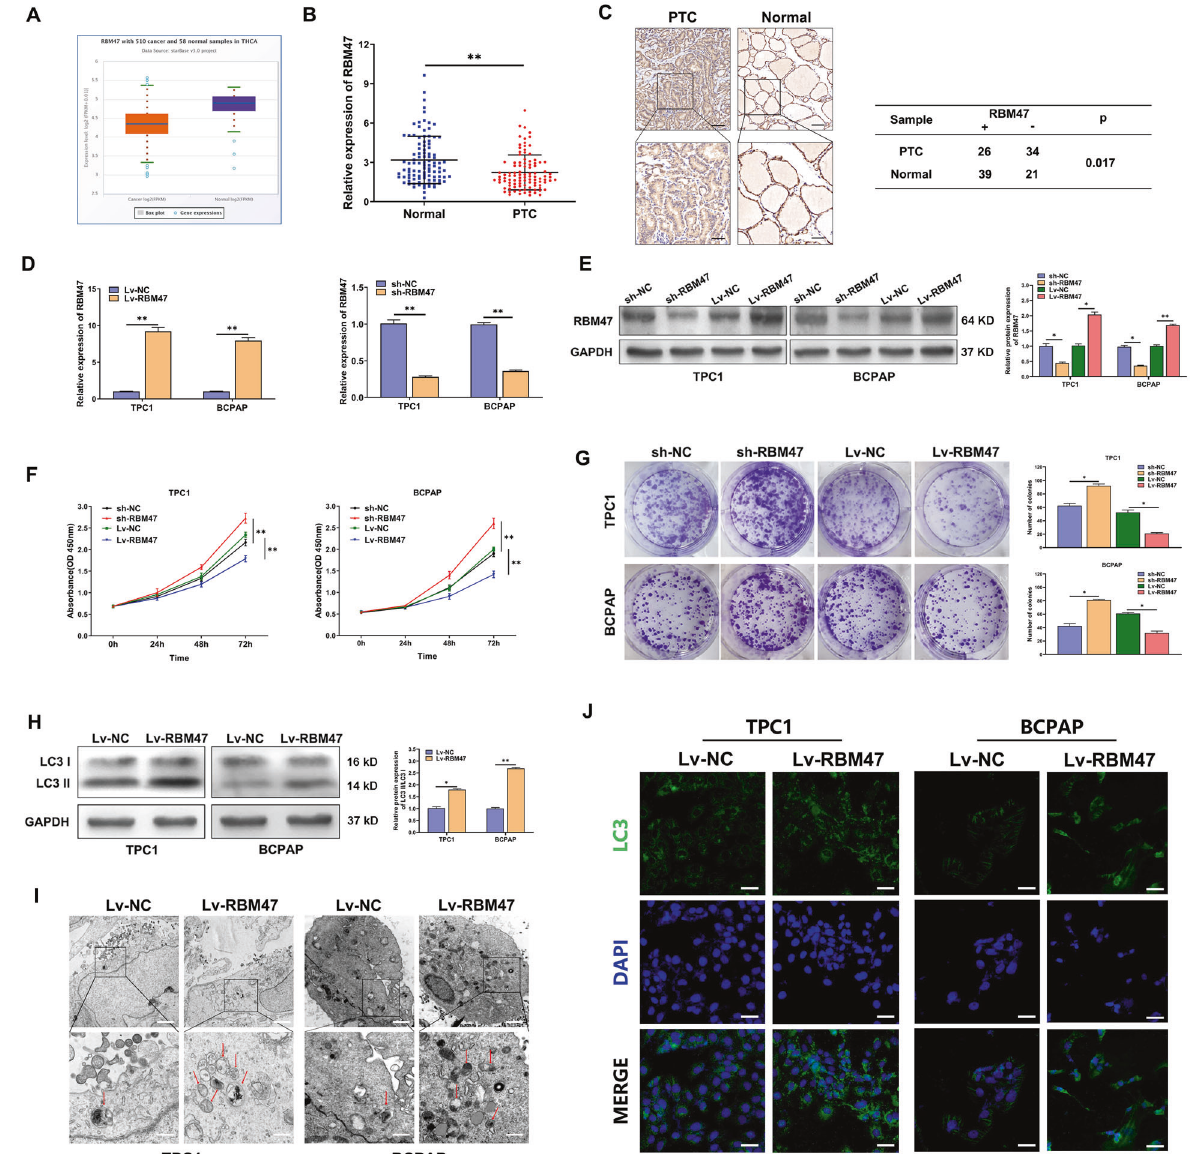
Fig. 1 RBM47 inhibits proliferation and activates autophagy in PTC cells. A RBM47 expression in PTC tissues and normal tissues from TCGA database. B The relative mRNA expression of RBM47 in 100 paired PTC tissues and adjacent non-cancerous tissues. C Representative RBM47 IHC staining of PTC tissues and matched adjacent non-cancerous tissues. Scale bar = 50 μ m (Upper) and 20 μ m (Below). D , E The transfection ef fi ciency of sh-RBM47 and Lv-RBM47 assessed by qRT-PCR and WB in TPC-1 and BCPAP cells. F , G Proliferation of RBM47-silenced or -overexpressed cells evaluated by CCK-8 assay and plate colony assay. H – J LC3 II/LC3 I ratio detected by WB, LC3 puncta evaluated by IF and autophagosomes shown by TEM (red arrow) in PTC cells with RBM47 upregulation. Scale bar in TEM = 5 μ m (Upper) and 1 μ m (Below), Scale bar in IF = 20 μ m. Statistical differences were analyzed using the independent samples t-test; data are shown as the mean ± standard error of the mean based on three independent experiments. * p < 0.05, ** p <